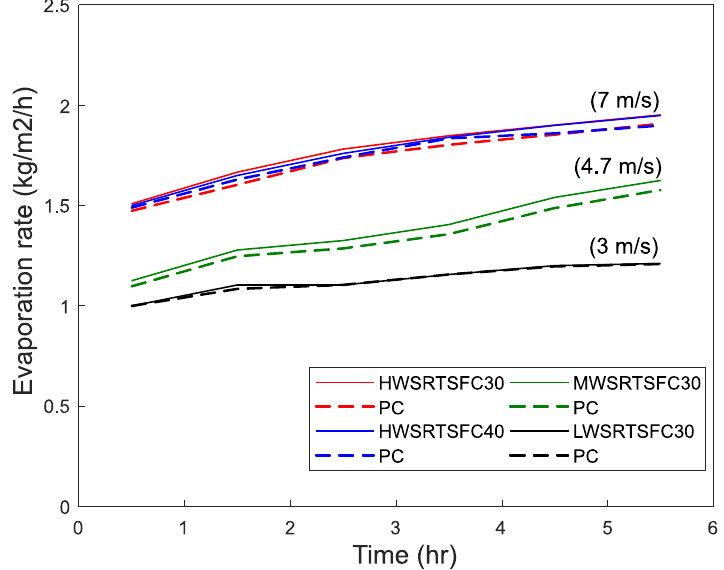
Figure 9. Effect of wind speed on evaporation rates (T = 36 C).